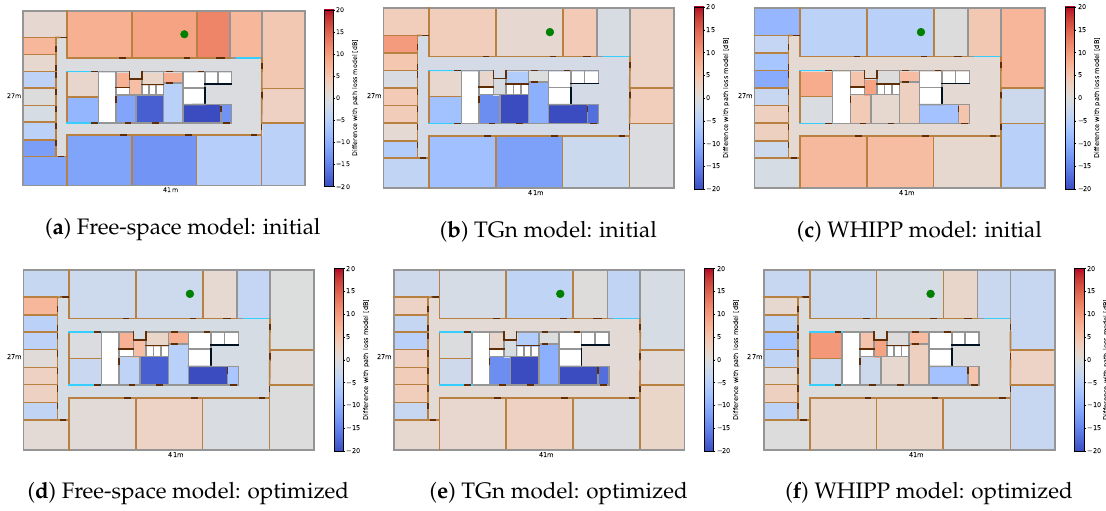
Figure 4. Average difference between model-based radio map and measurements, grouped per room, for one access point (green dot), before ( a – c ) and after the unsupervised learning ( d – f ). The access point is indicated with a green dot and the color in each room indicates the average difference from the path loss model (after the conversion from RSS to path loss). A blue color